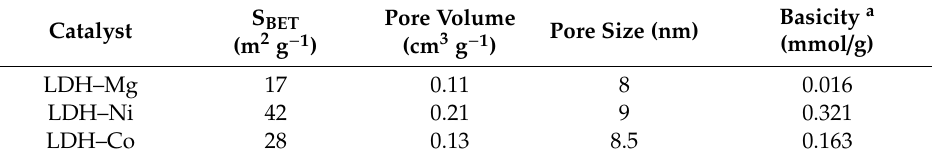
Table 2. Textural and basic properties determined by titration with 0.01 M benzoic